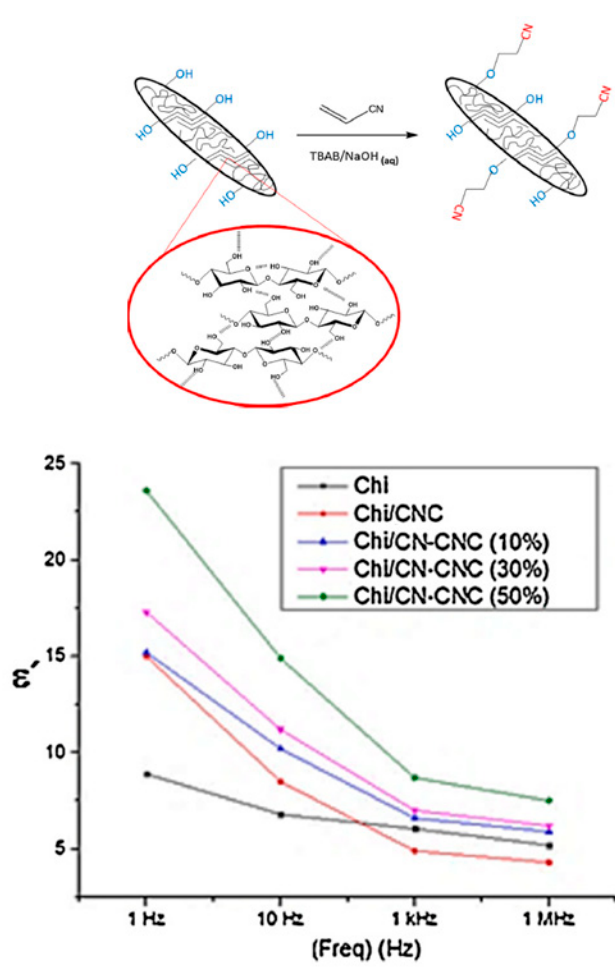
Figure 6. ε ’ values at different frequencies for chitosan, the nanocomposite with unmodified CNCs and those with different amounts of cyanoethylation of cellulose nanocrystals (CN-CNC). Adapted from reference [14] with permission. Copyright 2018, Elsevier.